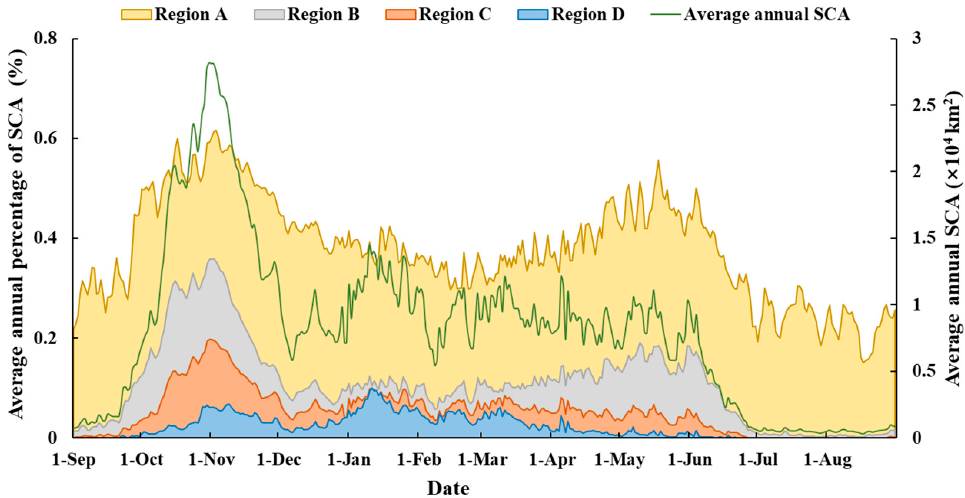
Figure 4. Intra-annual trends of 19-year mean SCA (2000–2019) in different elevation zones.